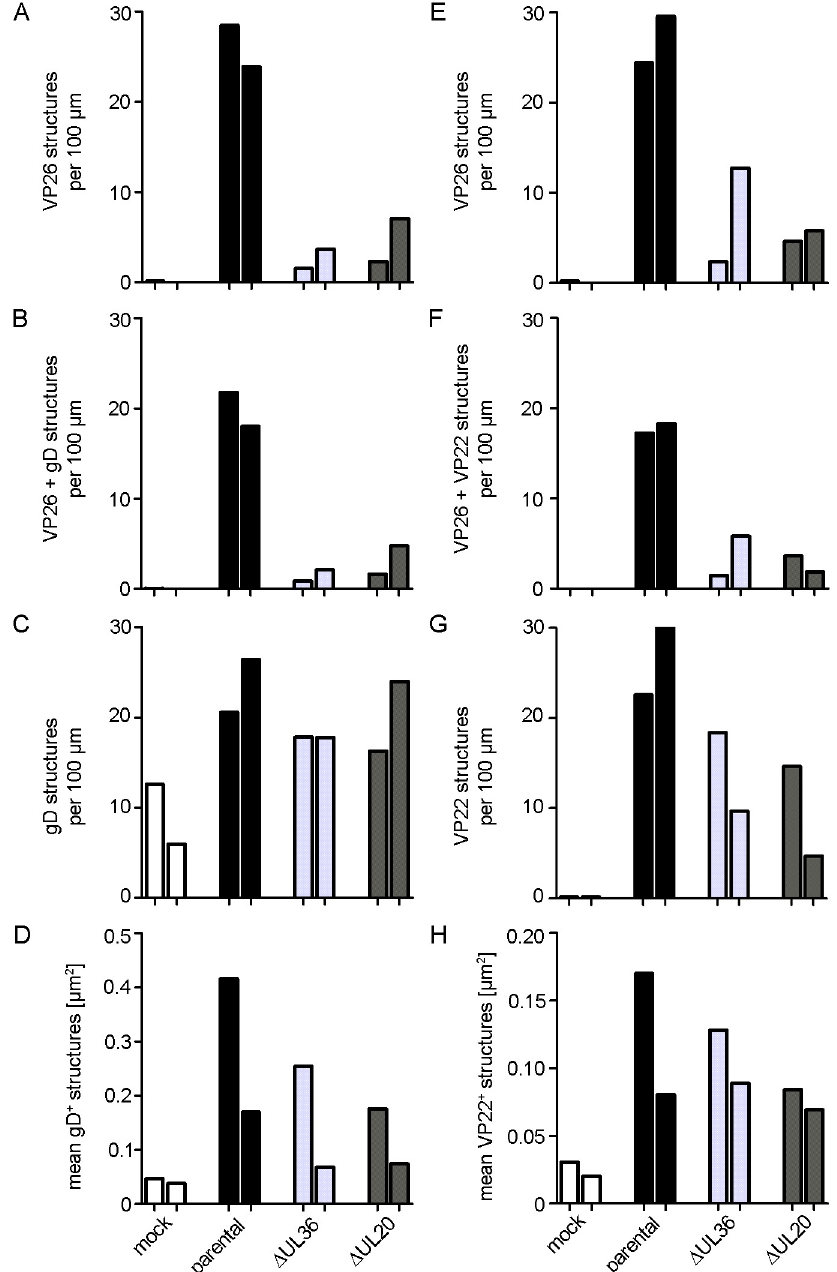
Fig 8. HSV1-pUL36, pUL37 and pUL20 are required for efficient targeting of capsids to axons. DRG neuronswere infected after 3 div with 1 x 10 7 pfu/mL of HSV1(17 + )Lox, Lox- Δ UL36, Lox- Δ UL37,or Lox- Δ UL20(or mock treated, fixed and permeabilizedusing the PHEMO protocol at 24 to26 hpi, labeledwith antibodies directed againstVP26 (pAb VP26 aa95-112 ) and gD (mAb DL6, A-D) or VP22 (mAb 22–3, E-H), and analyzedby confocal fluorescence microscopy.The images were quantified with a semi-automated algorithm. Each bar represents the mean from one experiment, normalizedto the parentalvalues. (A-D) Labelingwith anti-VP26and anti-gD: (A) Total number of VP26 positive structures. (B) VP26 and gD doublepositive structures. (C) total gD positive structures (D) Size of gD-positivestructures. (E-H) Labelingwith anti-VP26 and anti-VP22: (E) Total VP26 positive structures. (F) Total number of structures labeledfor VP26 and VP22. (G) Total number of structures labeledfor gD. (D) Area of structures labelledfor gD. The number of capsids, gD or VP22 structures, image numbers and total axon length are shown in S1